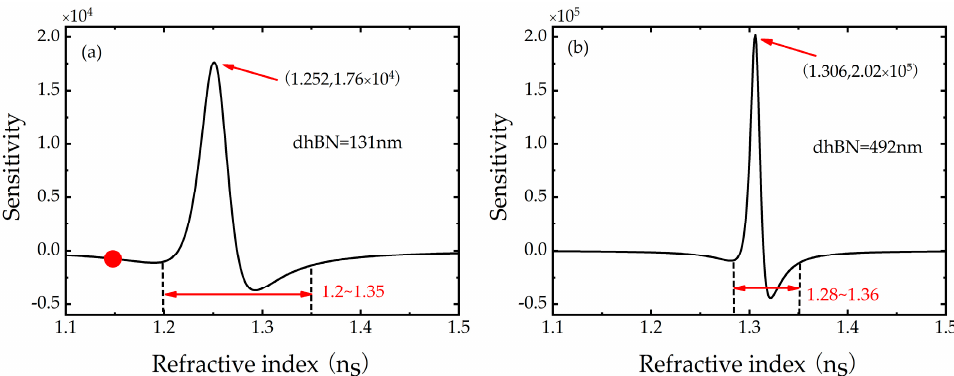
Figure 6. ( a ) Dependence of sensitivity of GH shift on refractive index ns of sensing layer when the hBN thickness is 131 nm, ( b ) Dependence of sensitivity of GH shift on refractive index ns of sensing layer when the hBN thickness is 492 nm, in which Fermi energy E F = 0.2 eV, Ag thickness d 2 = 15 nm, Au thickness d 3 = 20 nm, graphene layer N = 1.